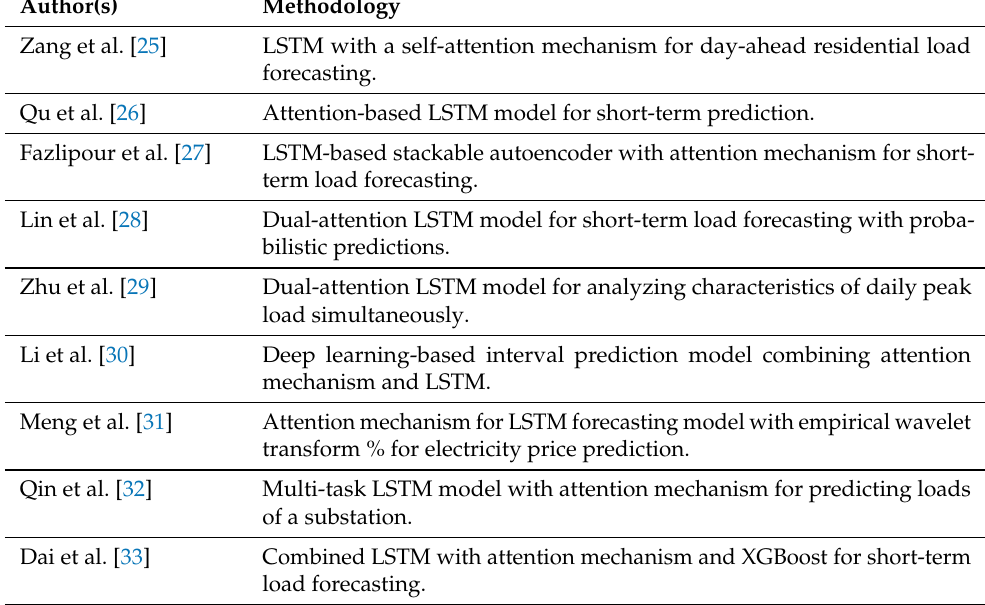
Table 1. Summary of LSTM for time series